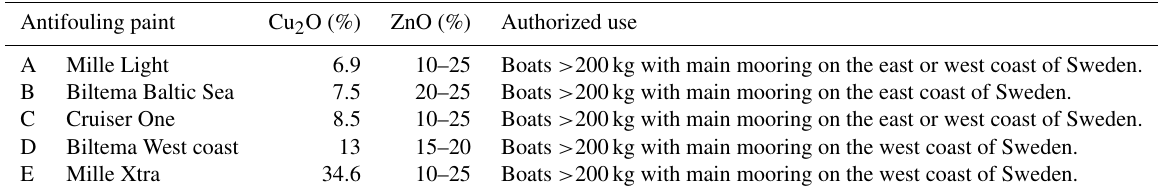
Table 3. Properties of the antifouling paints assumed to be used in the study. Data were obtained from the Swedish Chemical Agency’s pesticide register and from the paints’ safety data sheet and technical data